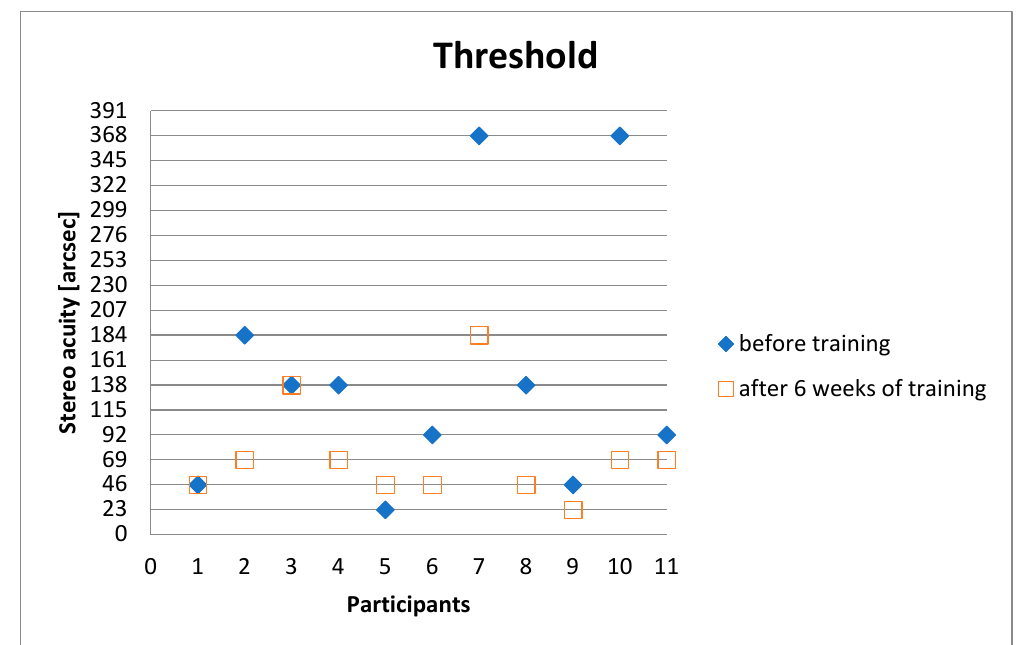
Figure 3. Stereo acuity thresholdof the static stereo test before training and after 6 weeks of training from all 11participants (11). Twenty-three arcseconds represents the most difficult level to detect and 368 arcsec the easiest level to detect. Each line corresponds to a disparity level and a different degree of difficulty. Table 1. Development of the stereo acuity in arcsec. Development of the stereo acuity in arcsec of the individual threshold before training and after six weeks of training, listing the difference in arcsec as well as the logarithmic of the difference.